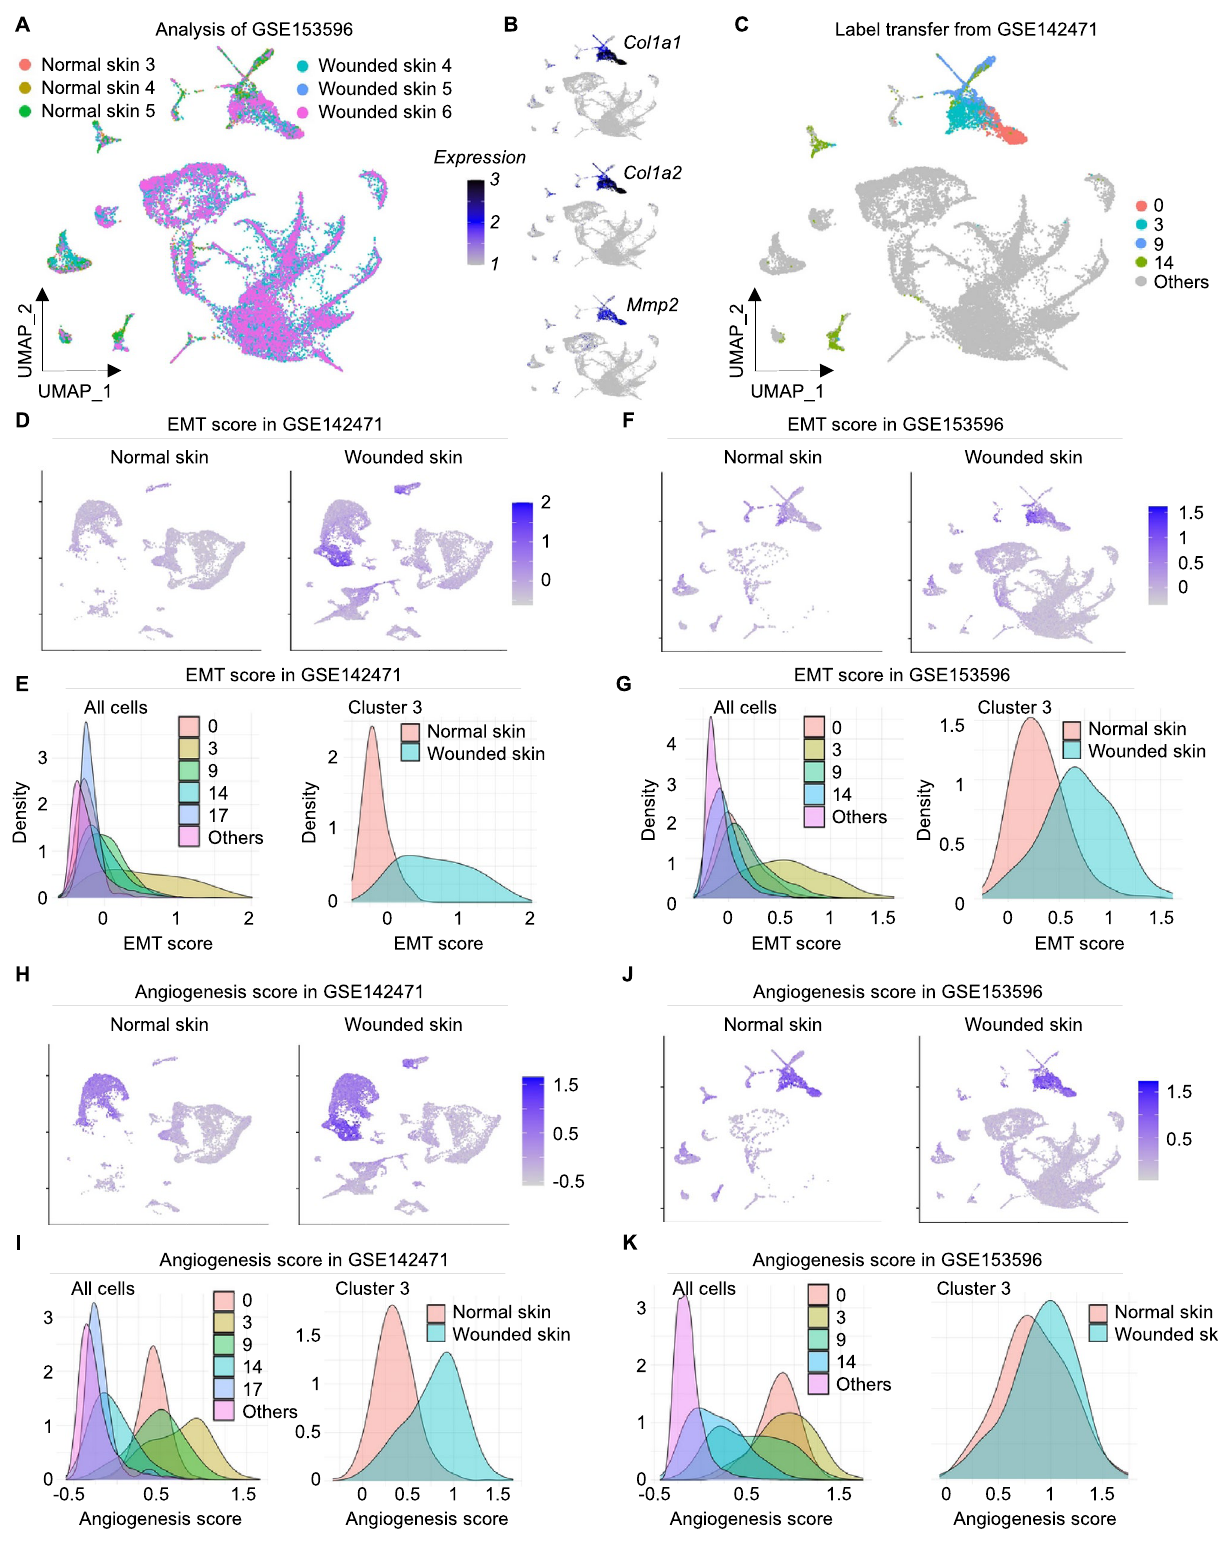
Figure 4. Upregulation of EMT and angiogenesis in cluster 3 fibroblasts at day 4 post-wound in mice skin. ( A ) UMAP representing cells from 3 normal skin and 3 wounded skin samples at day 7 post-wound retrieved from GSE153596. ( B ) Expression level of Col1a1, Col1a2 and Mmp2. ( C ) UMAP plot representing cells from GSE153596 labeled using mutual nearest neighbor and label transfer (see methods) from GSE142471. ( D ) EMT score in cells from GSE142471. ( E ) Left panel represents EMT score in fibroblast clusters and other cell types. Right panel represents EMT score in cluster 3-like cells from GSE142471 in normal and wounded skin. ( F ) EMT score in cells from GSE153596. ( G ) Left panel represents EMT score in fibroblast clusters and other cell types. Right panel represents EMT score in cluster 3-like cells from GSE153596 in normal and wounded skin. ( H - I ) Angiogenesis score in cells from GSE142471 in all cells and in cluster 3 fibroblasts. ( J - K ) Angiogenesis score in cells from GSE153596 in all cells and in cluster 3